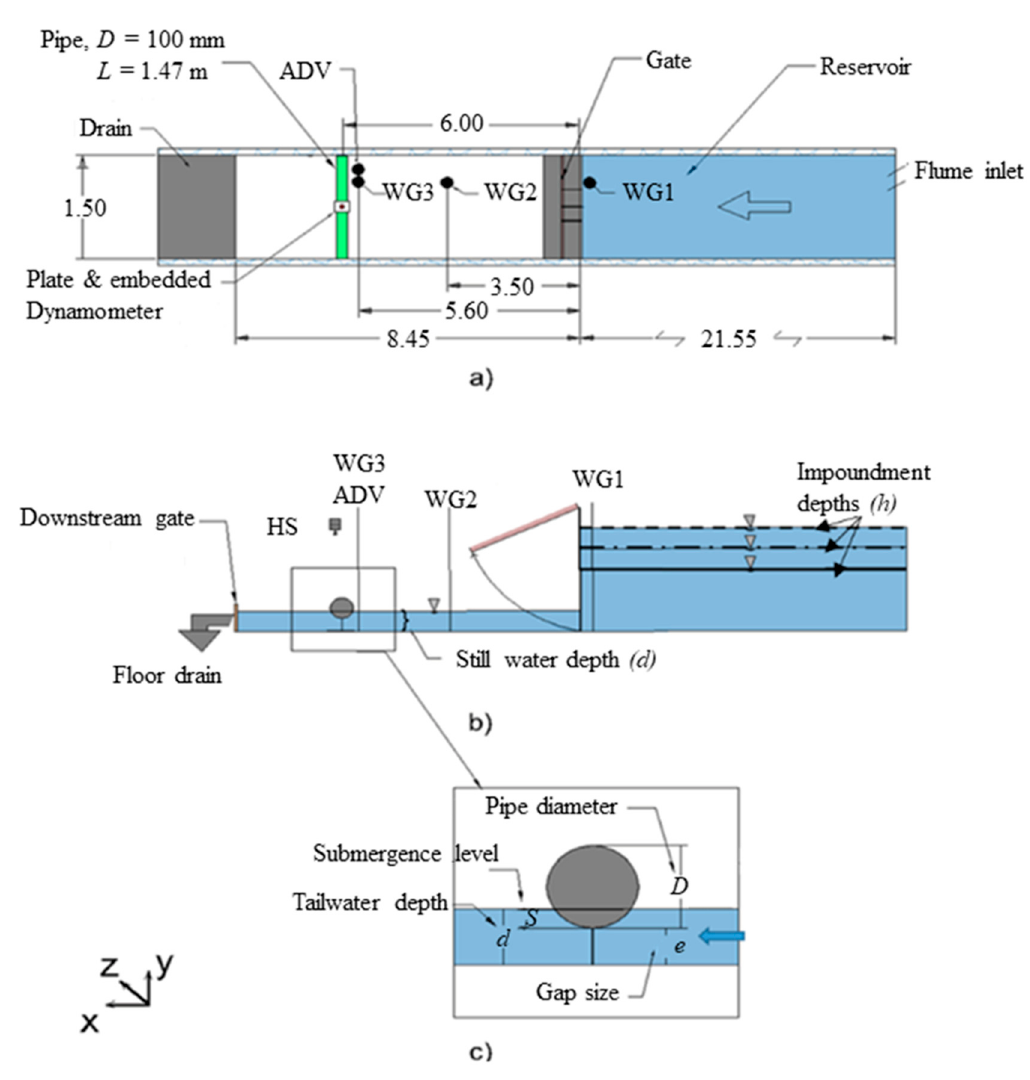
Figure 2. Experimental setting and instrument locations (unless otherwise specified, all dimensions are in m): ( a ) plan view, ( b ) side view, and ( c ) close view.